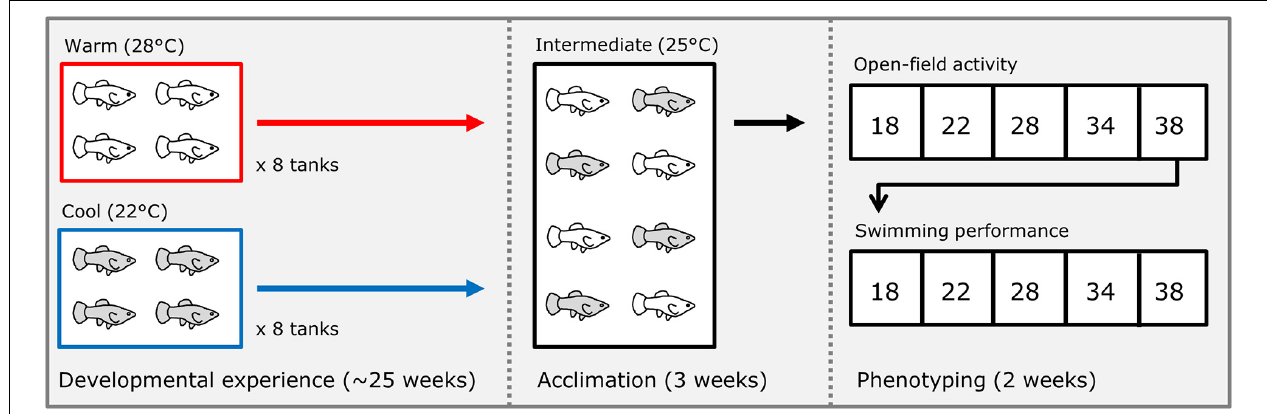
FIGURE 1 | Schematic of experimental design. Immediately after birth, broods of Poecilia formosa and Poecilia mexicana were split into either a “warm” or “cool” treatment where they developed for approximately 25 weeks. After this time, fish were then acclimated to an intermediate temperature for 3 weeks. After acclimation, each fish was tested for their open field movement and swimming performance at five different temperatures (in random order) over the course of 2 weeks.